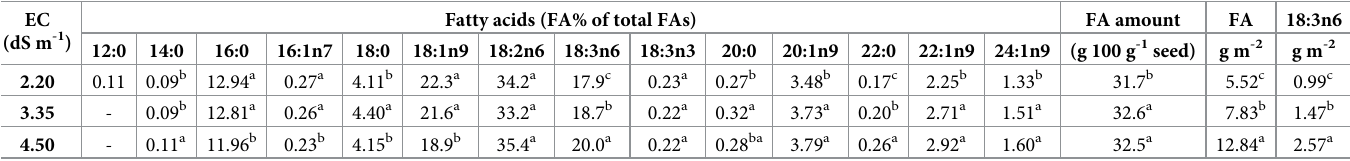
Table 4. Fatty acid (FA) levels in borage (B. officinalis L.) crop seeds for different nutrient solution electrical conductivity (EC) values. EC (dS m -1